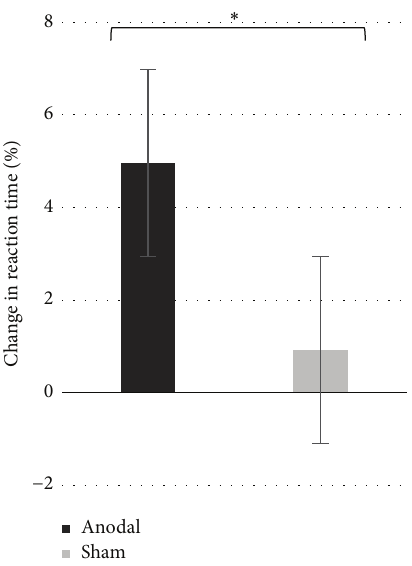
Figure 4: Mean sequence-specific learning (percent change in RT) across training sessions per group. Table 3: Response accuracy (percentage of correct